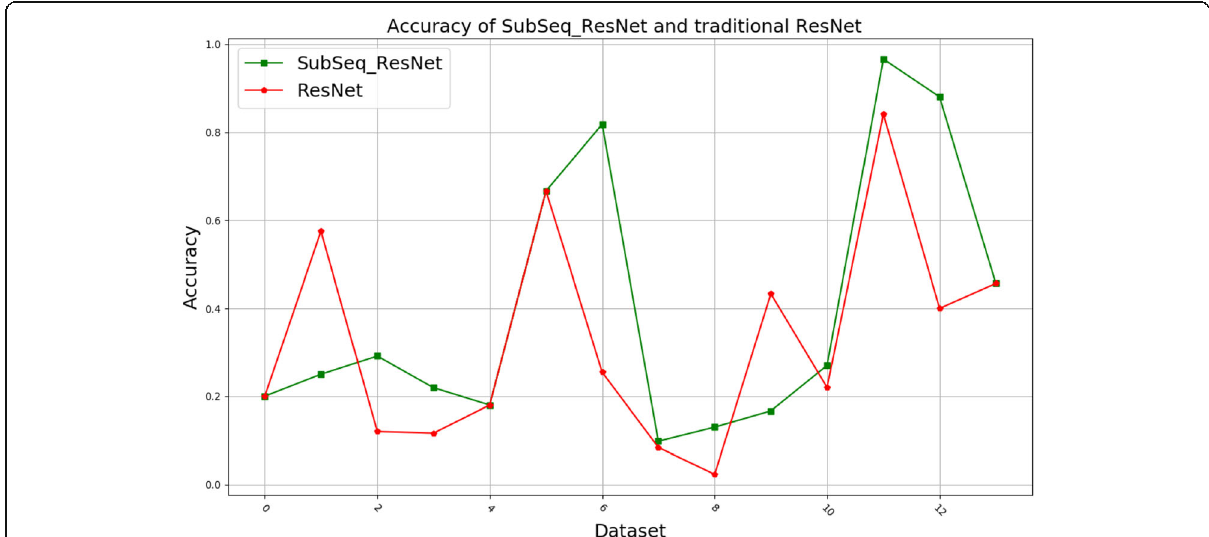
Fig. 11 The accuracy of the original sequence and feature subsequence on ResNet